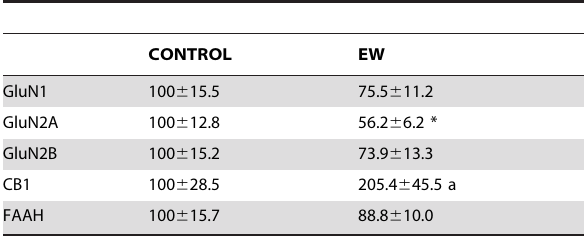
Table 1. Ethanol withdrawal (EW) decreases GluN2A mRNA